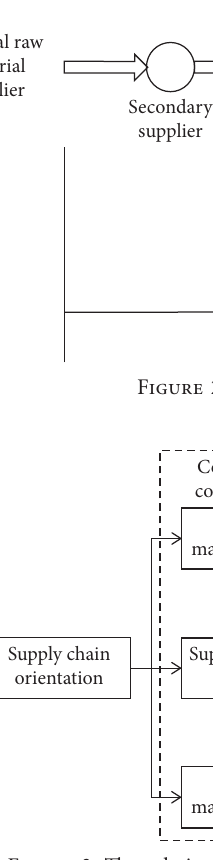
Figure 3: The relationship between logistics capabilities and supply chain